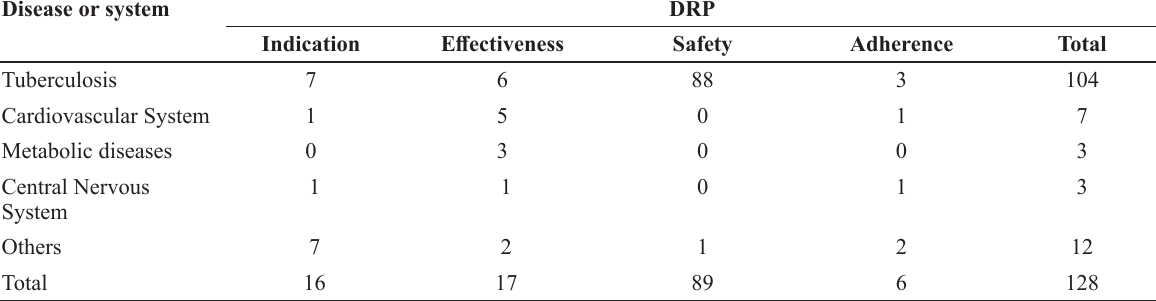
Distribution of Drug-Related Problems per tuberculosis and system (n =